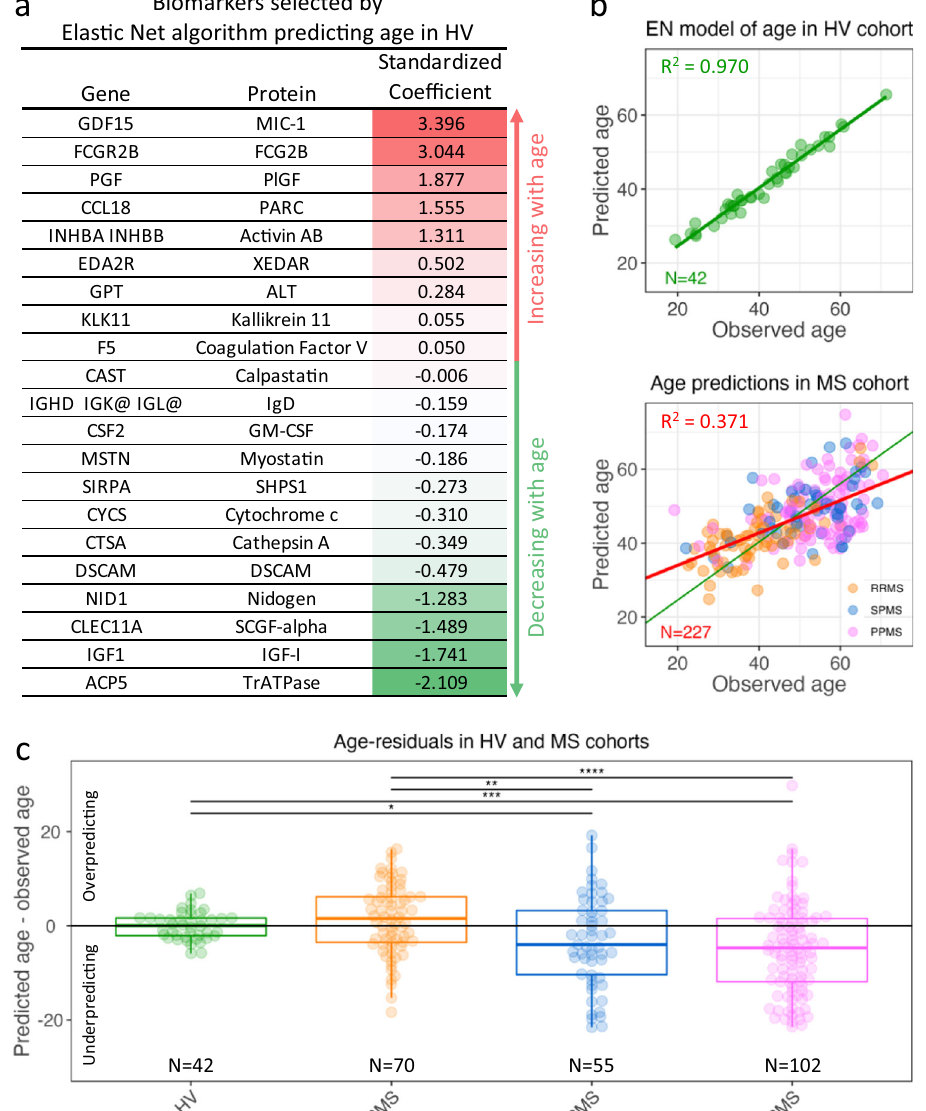
comparisons of the diagnostic groups using two-sided Wilcoxon test and false- discovery rate (FDR) adjustment for multiple comparisons ( p <0.0001 ****, p <0.001 ***, p <0.01 **, p <0.05 *). Exact FDR-adjusted p -values for individual comparisons: HV-SPMS: p =0.049, HV-PPMS: p =0.00058, RRMS-SPMS: p =0.0072,RRMS-PPMS: p =2.3×10 -5 .Thelowerandupperhingesoftheboxplots correspond to the fi rst and third quartiles (the 25th and 75th percentiles). The upper whisker extends from the hinge to the largest value no further than 1.5*interquartilerange(IQR)from the hinge.Thelowerwhisker extends from the hingetothesmallestvalueatmost1.5*IQRofthehinge.Sourcedataareprovided as a Source Data fi